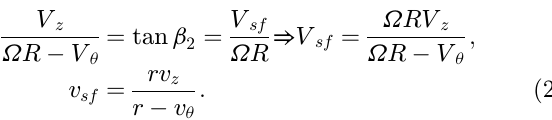
∗ h ) versus normalized